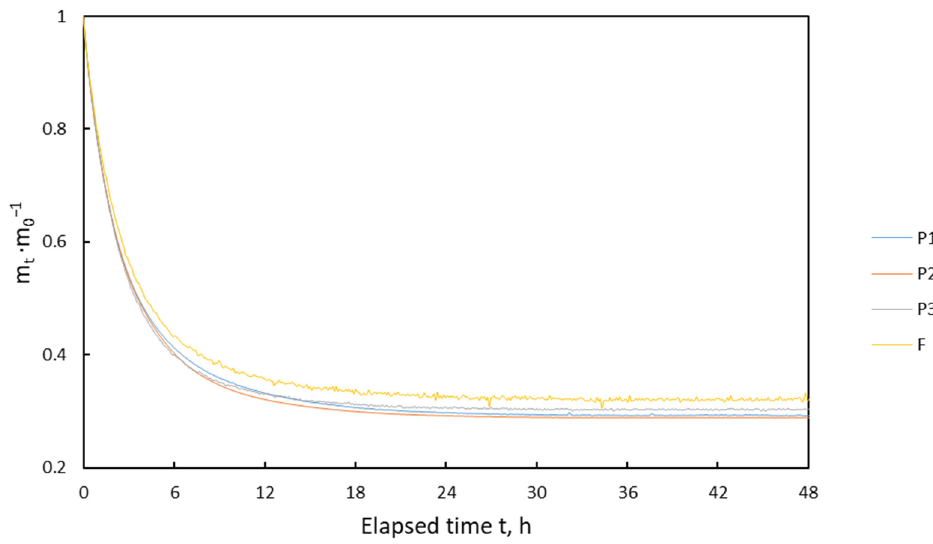
Figure 11. Mass ratio vs. time; normalized sample masses during drying of fresh nettles in the HPD TP3+; T set = 40 °C, RH set = 20%, v set = 0.2 m · s − 1 .